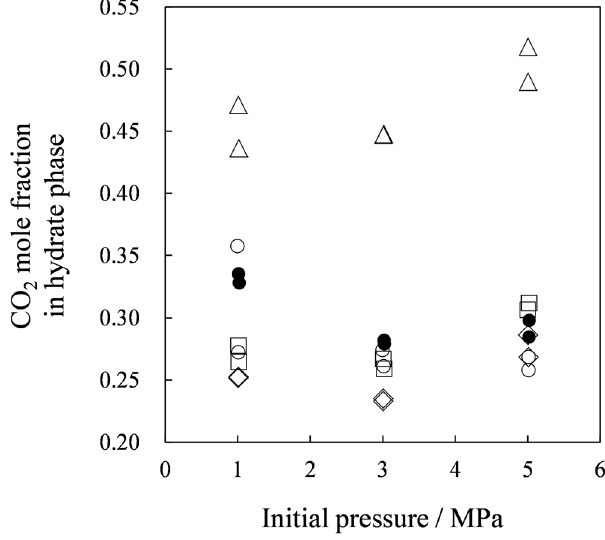
Figure 3. CO 2 mole fraction in hydrate phase. The symbols show ionic guest substances: ● , TBAB with w = 0.320; ○ , TBAB with w = 0.200; △ , TBAC with w = 0.200; □ , TBPB with w = 0.200; ◊ , TBPC with w =